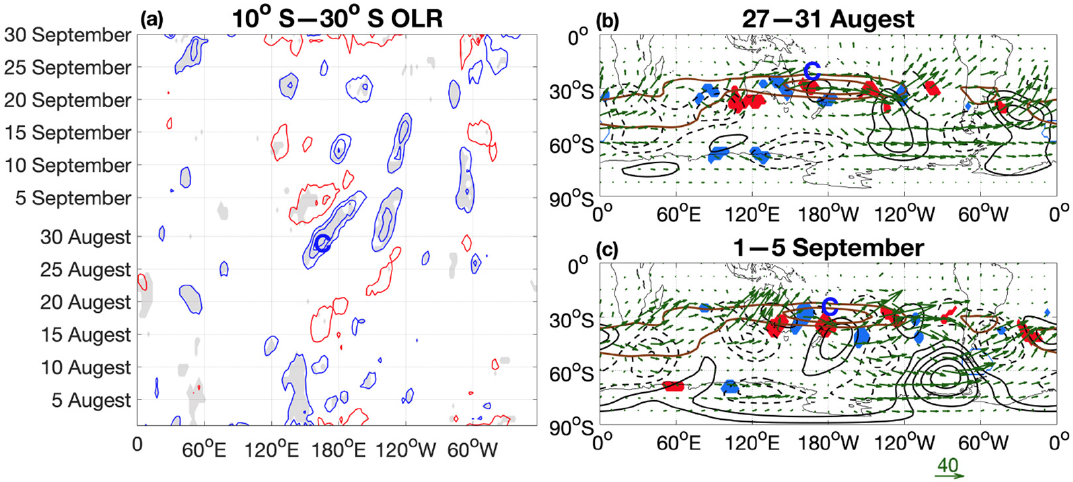
Figure 7. ( a ) Longitude-time cross section of 5 day running-mean outgoing longwave radiation (OLR) anomalies (contours; interval: 10 W/m 2 ) averaged from 10° S to 30° S for August–September, 2019. Gray shadings denote the positive (negative) anomalies exceeding the 90% percentile (below 10% percentile) of the OLR distributions over each calendar day at a given longitude point during 2002–2019. The geopotential height anomalies (black solid and dashed contours; interval: 70 m), JAS-mean zonal wind in 2019 (brown contours; 35 m/s and 45 m/s are contoured), horizontal component of Rossby wave activity flux (green arrows) at the 250 hPa level for ( b ) 27–31 August and ( c ) 1–5 September 2019. Solid (dashed) contours denote the positive (negative) anomalies. Red (blue) shadings denote the areas where the anomalous Rossby wave source at the 250 hPa level exceeding 4.5 × 10 − 5 (below − 4.5 × 10 − 5 ) s − 1 /day. The blue label “C” denotes the anomalous deep convection suggested by negative OLR anomalies. The scaling of the arrows is given at the bottom-right side (m 2 s − 2 ).